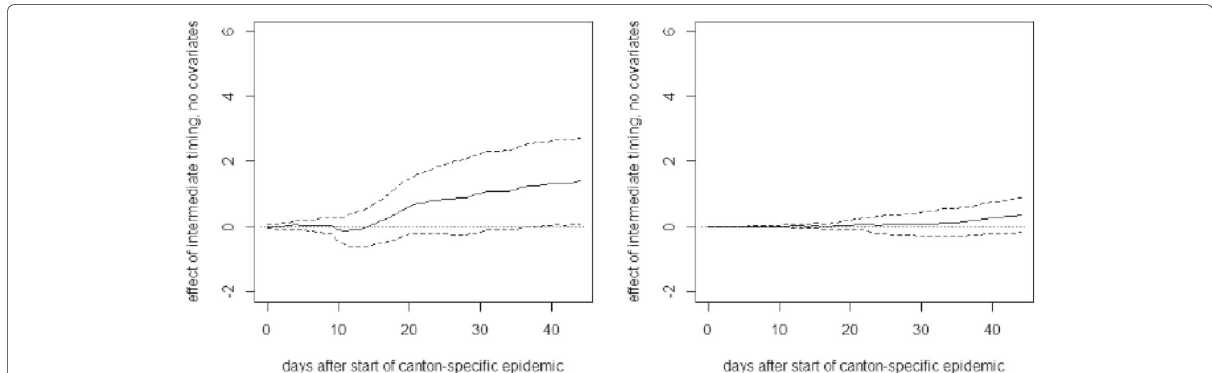
Fig. 14 OLS effect of intermediate timing of measures on cumulative hospitalizations (left) and deaths (right) per 10,000 inhabitants without covariates excluding Ticino